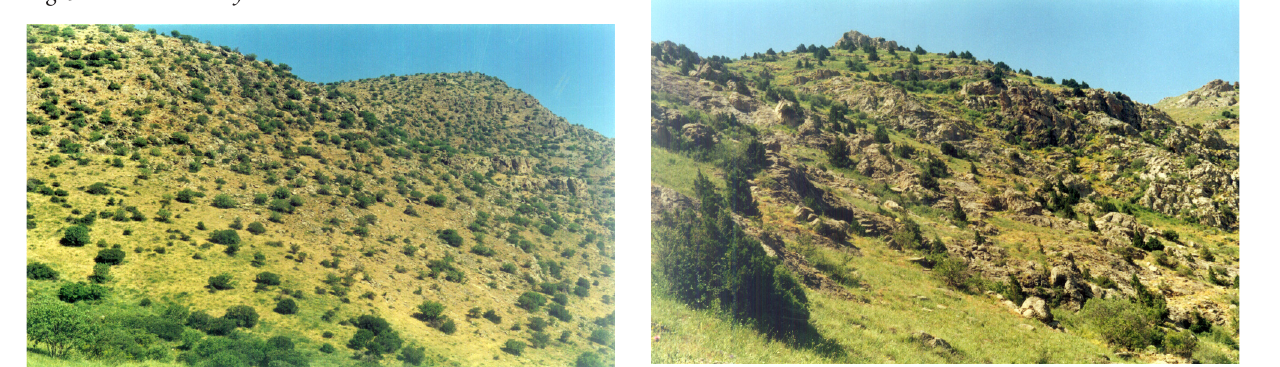
Fig. 10. Juniperus